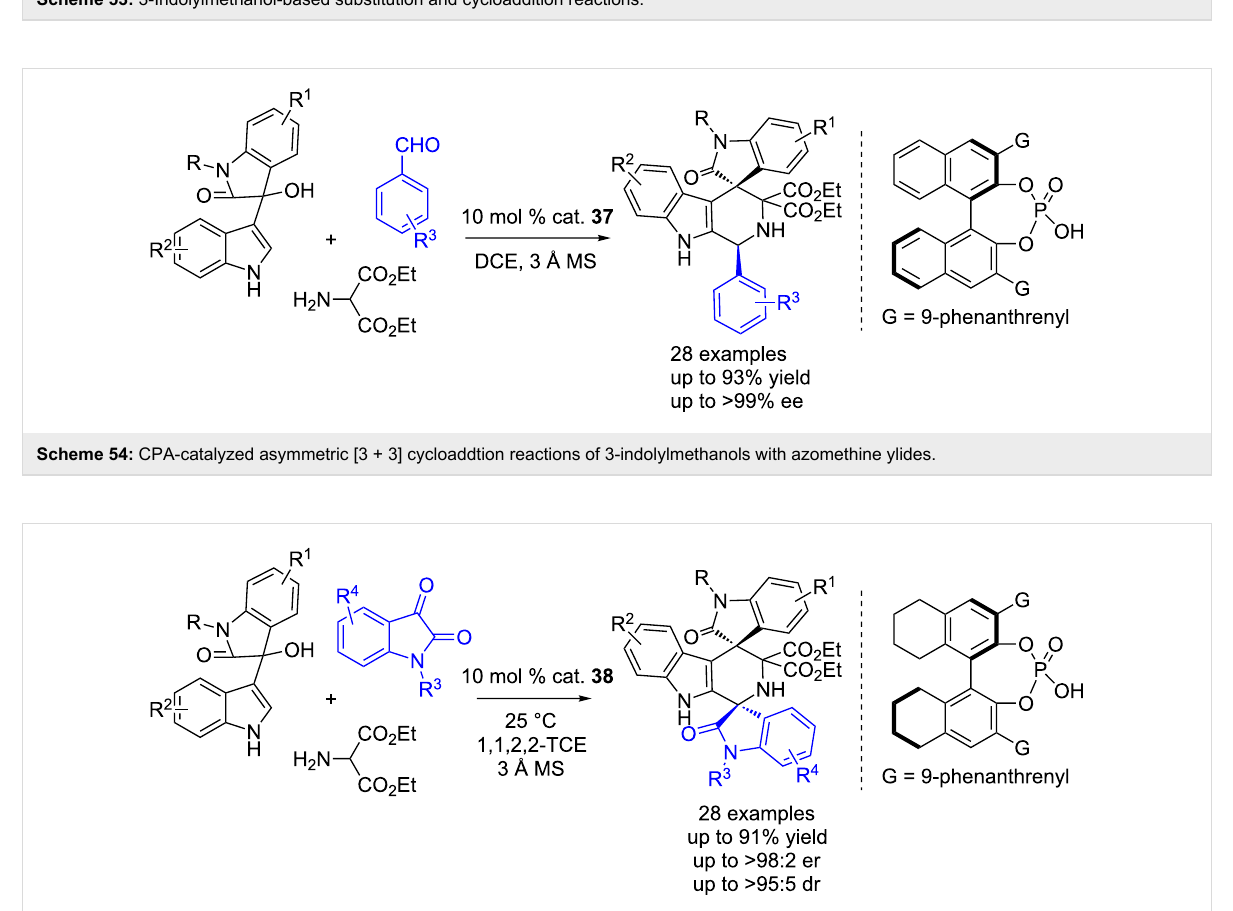
Scheme 53: 3-Indolylmethanol-based substitution and cycloaddition reactions.